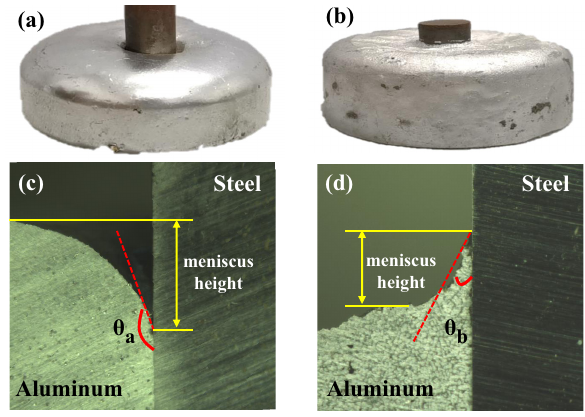
Figure 3: Macro - characteristics of the steel/aluminum bimetallic castings fabricated with and without ultrasonic treatment: ( a ) and ( c ) without ultrasonic; ( b ) and ( d ) with